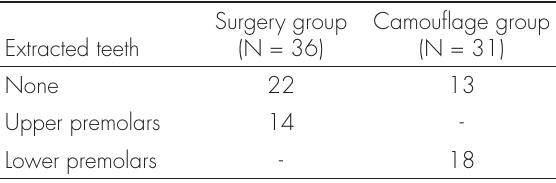
Table I. Extraction protocols for surgery and camouflage